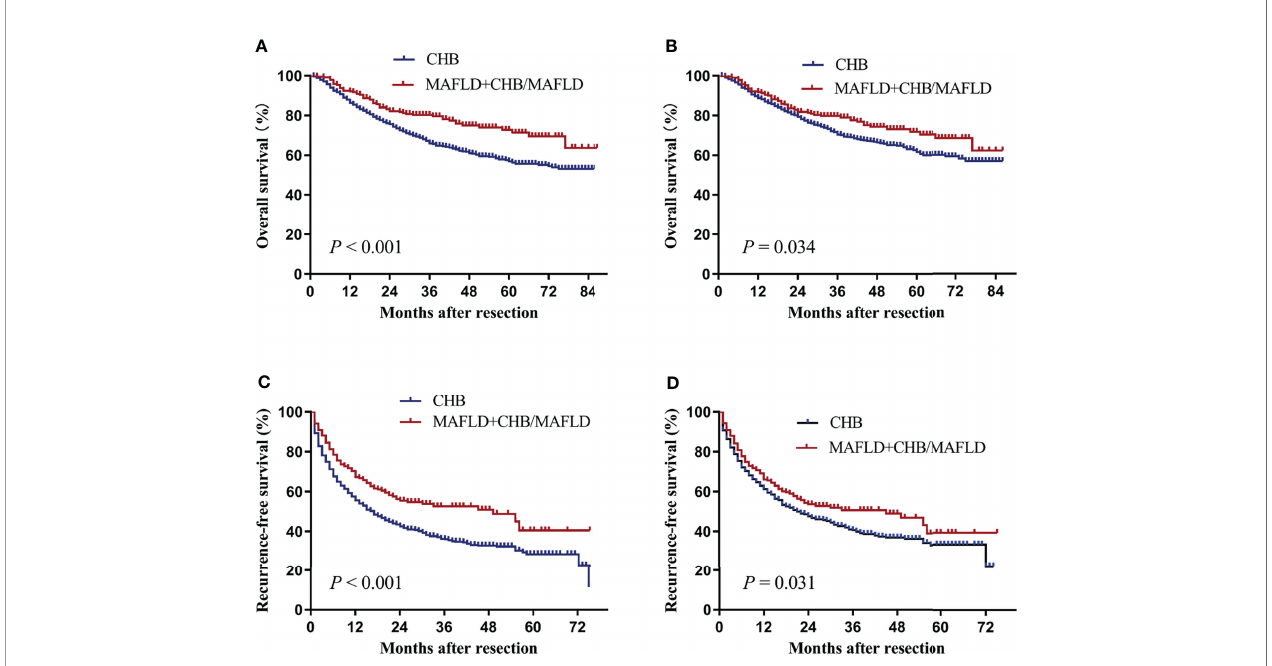
FIGURE 4 | Kaplan – Meier analysis of overall and recurrence-free survival for the MAFLD plus CHB/MAFLD and CHB counterparts. (A) Overall survival before propensity matching, (B) overall survival after propensity matching, (C) recurrence-free survival before propensity matching, (D) recurrence-free survival after propensity matching. CHB, chronic hepatitis B; MAFLD, metabolic dysfunction-associated fatty liver